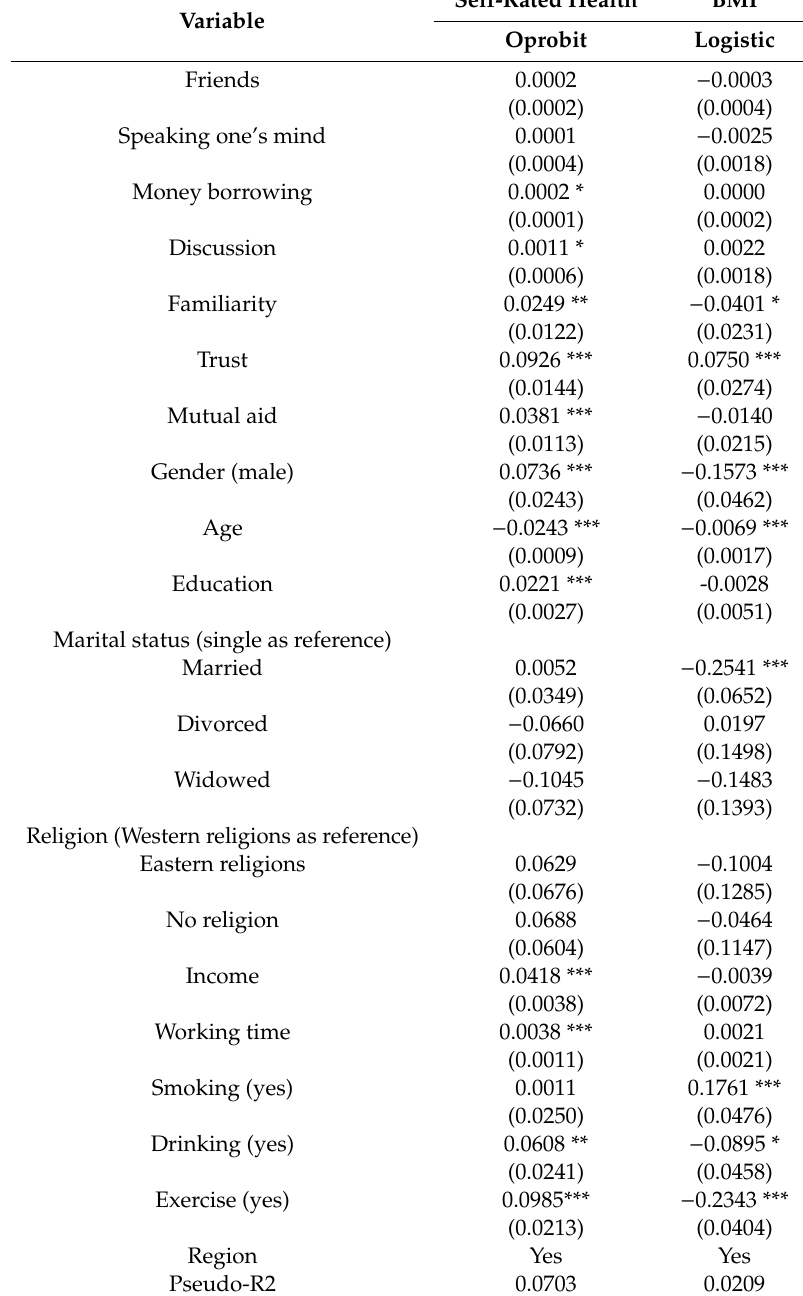
Table 2. Influence of social support on physical health ( N =